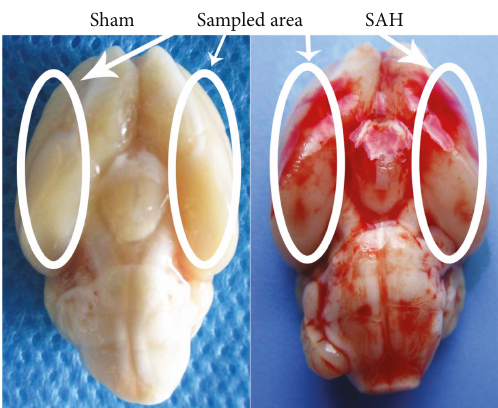
Figure 1: Sample collection location and rat SAH model.